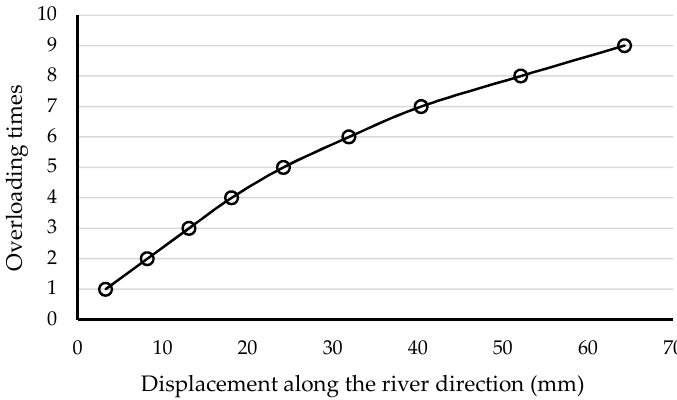
Figure 10. The capacity curve of the maximum displacement along river direction of the arch crown.